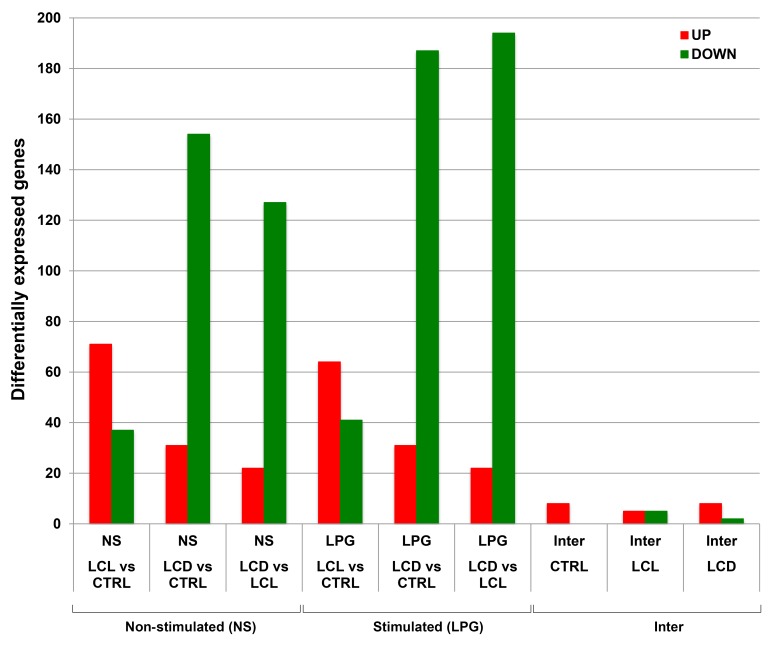
Differentially expressed genes on all nine contrasts.Bars in green represent down-regulated genes and in red those up-regulated. The Y axis represents the number of differentially expressed genes. The last six bars on the far right (Inter) show the effect of LPG stimulation (6 h) on NK cells of controls, LCL and DCL patients, revealing an almost negligible effect in all three groups. Non-stimulated NK cells (NS), LPG-stimulated NK cells (LPG) and comparison between LPG vs NS (Inter). Healthy controls (C), localized cutaneous leishmaniasis patients (LCL), diffuse cutaneous leishmaniasis patients (DCL).